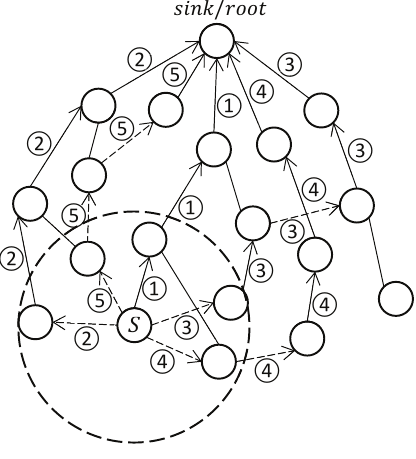
Figure 9. An Example of